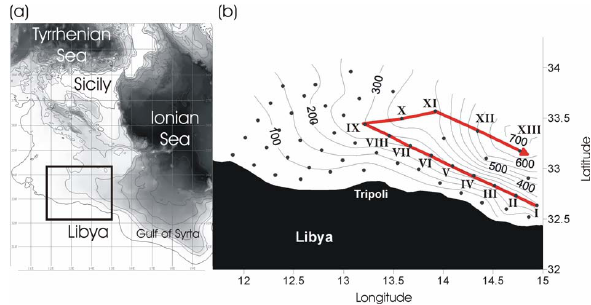
Fig. 1. (a) Sicily channel and western Ionian Sea. The rectangle Figure 1. (a) Sicily channel and western Ionian Sea. The rectangle delimits the investigated delimits the investigated region; (b) detailed cruise map. Dots indi- region; (b) detailed cruise map. Dots indicate the CTD and LADCP stations. The red line cate the CTD and LADCP stations. The red line indicates the main indicates the main trajectory of the vein. Roman numbers indicate the stations along the main trajectory of the vein. Roman numbers indicate the stations along trajectory. the main